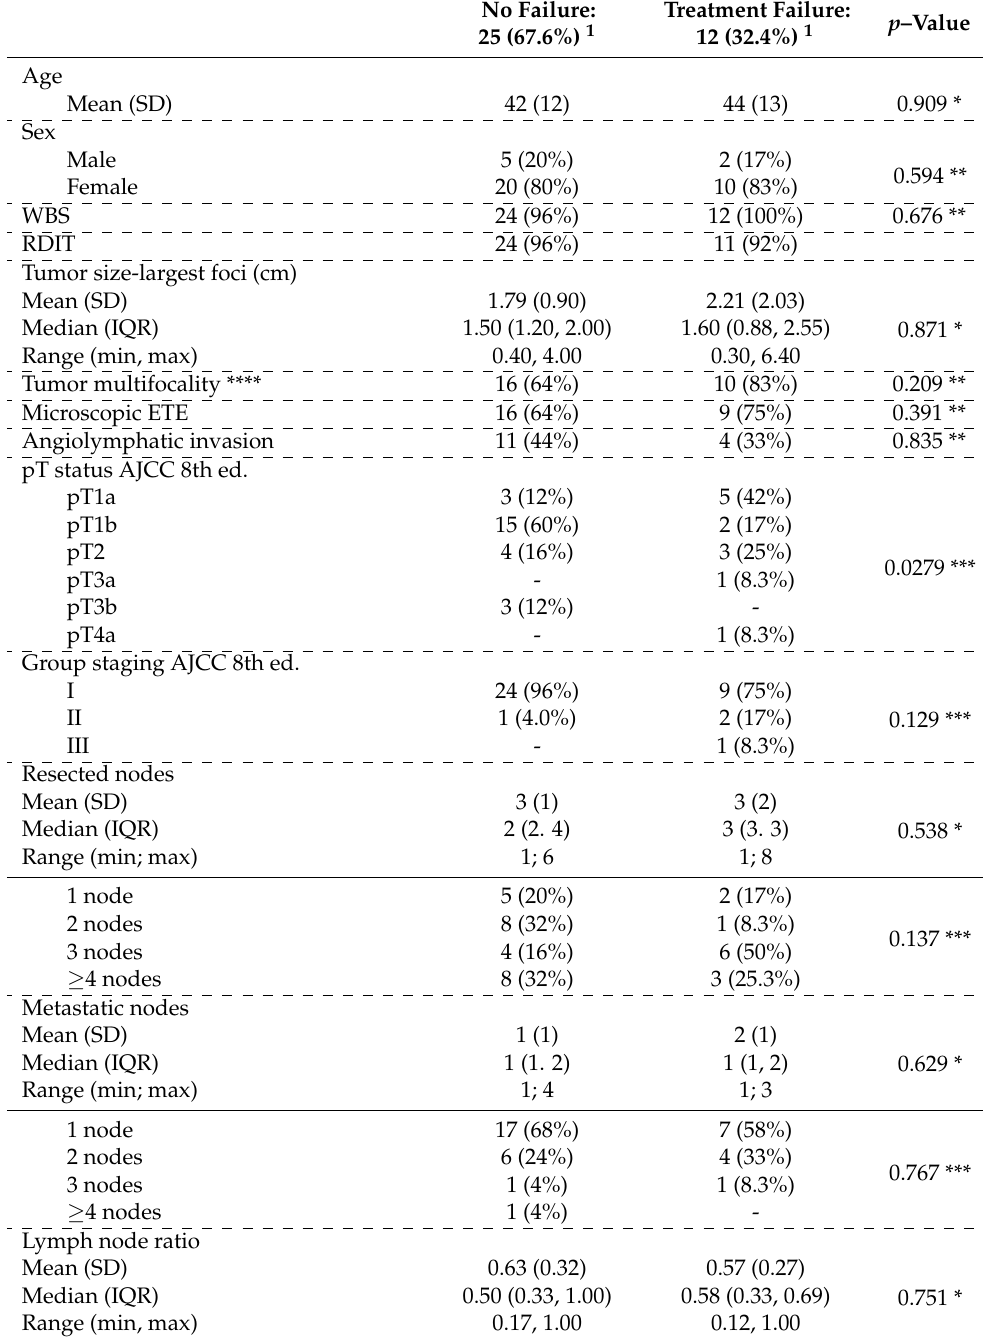
Table 6. Exploratory characteristics of the patients from Group 3 (patients submitted to total thyroidec- tomy with incidental lymph node resection and lymph node metastasis) divided by treatment